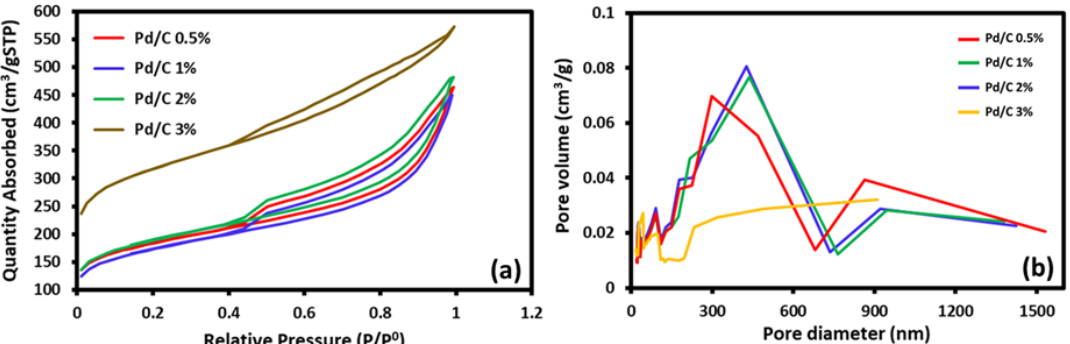
Figure 4. ( a ) Adsorption–desorption isotherms of the 0.5% Pd/C, 1% Pd/C, 2% Pd/C and 3% Pd/C catalysts. ( b ) Pore size distributions of the 0.5% Pd/C, 1% Pd/C, 2% Pd/C and 3% Pd/C catalysts.